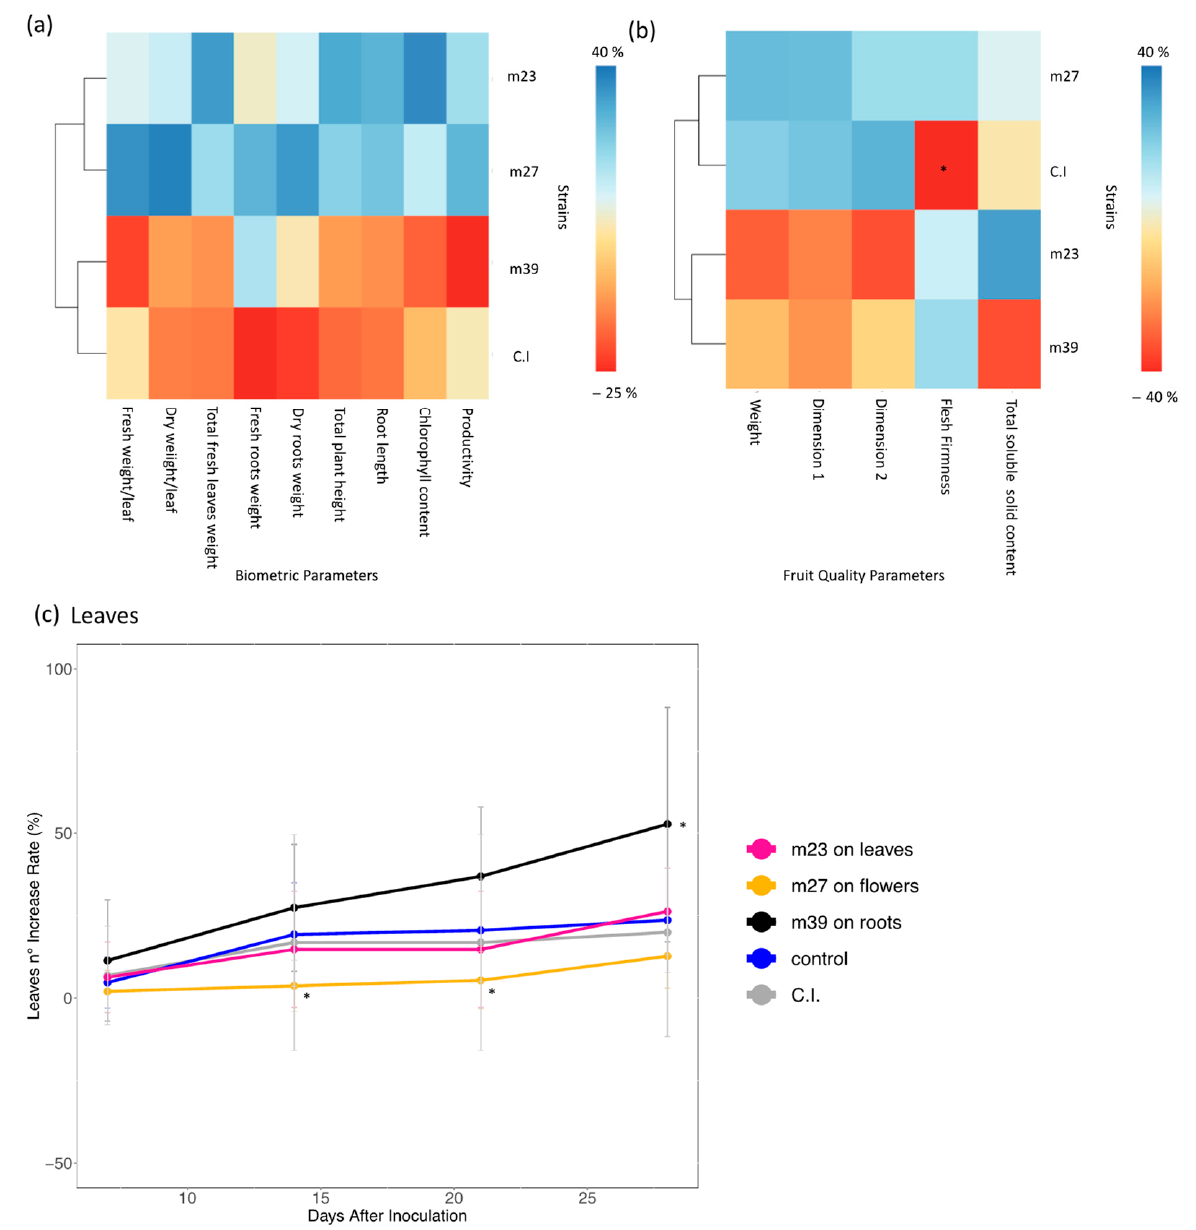
Figure 6. Plant growth biometric parameters ( a ) and fruit quality parameters ( b ) heatmaps of individually and coordinated inoculated plants, expressed as percentage increase/decrease with respect to the control plants. The color scale ranges from red (lower values with respect to the control) to blue (higher values with respect to the control). Leaf growth over time ( c ) after individual or coordinated inoculation. Asterisks indicate parameters significantly different from the control, according to Student’s t -test at p -value < 0.05.